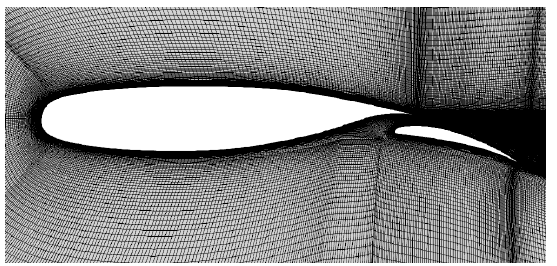
Figure 16. Mesh for calculation of NLR 7301 two-segment airfoil. Table 3. A comparison of aerodynamic coefficient of NLR 7301 two-segment airfoil calculated by different models. Angle of Attack Drag Coefficient Lift Coefficient SA-NN 6